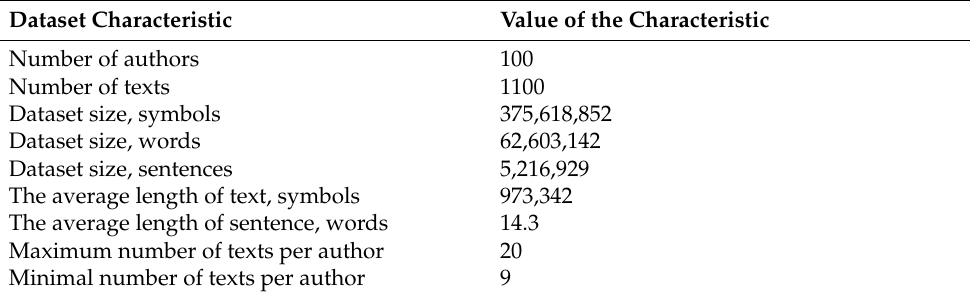
Figure 1. The methodology of the study. Table 1. Description of the literary texts’